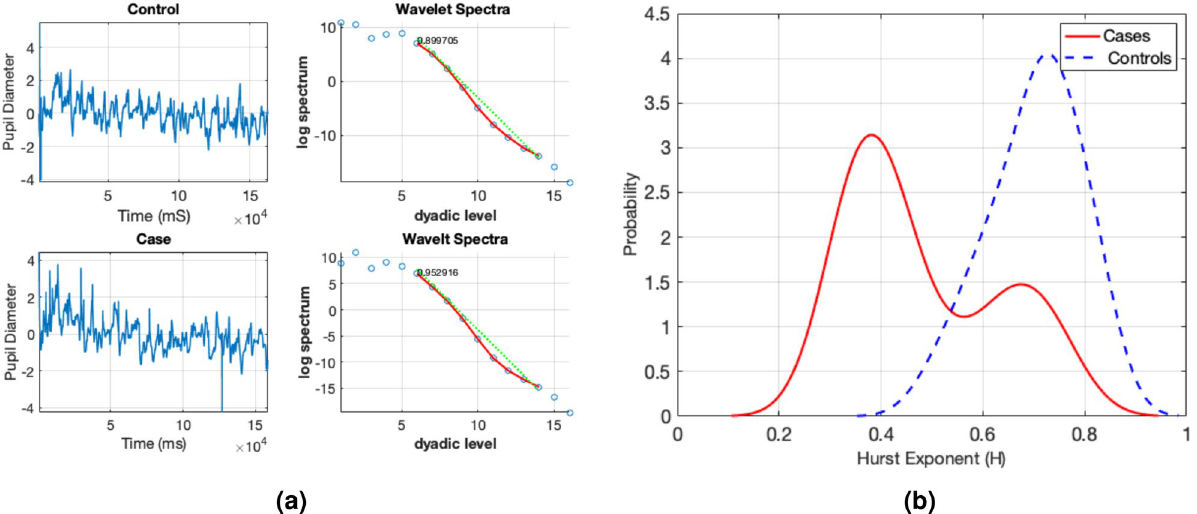
Figure 5. Self-similarity in pupil diameter: ( a ) a sample pupil diameter signal (one session) and its wavelet spectra along with estimated Hurst exponent and ( b ) distribution of Hurst exponent for controls and cases